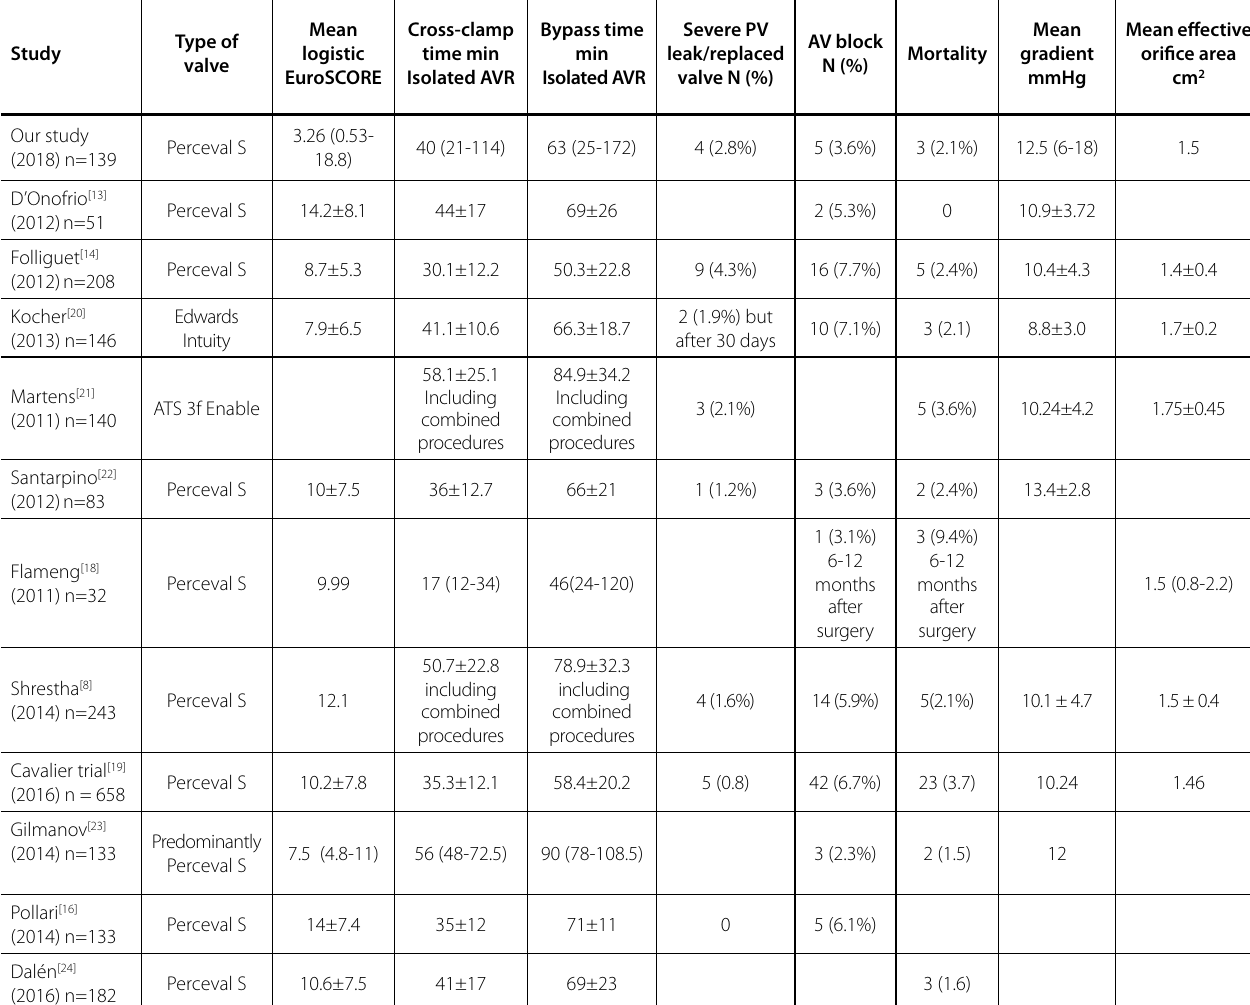
Table 4. Comparison of our results with other published series using sutureless